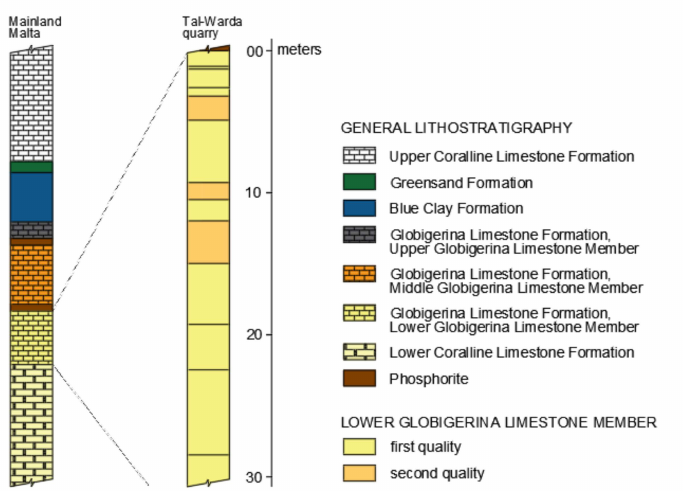
Figure 5. A lithostratigraphic column of Tal-Warda quarry with respect to the general stratigraphy of the Maltese Islands.